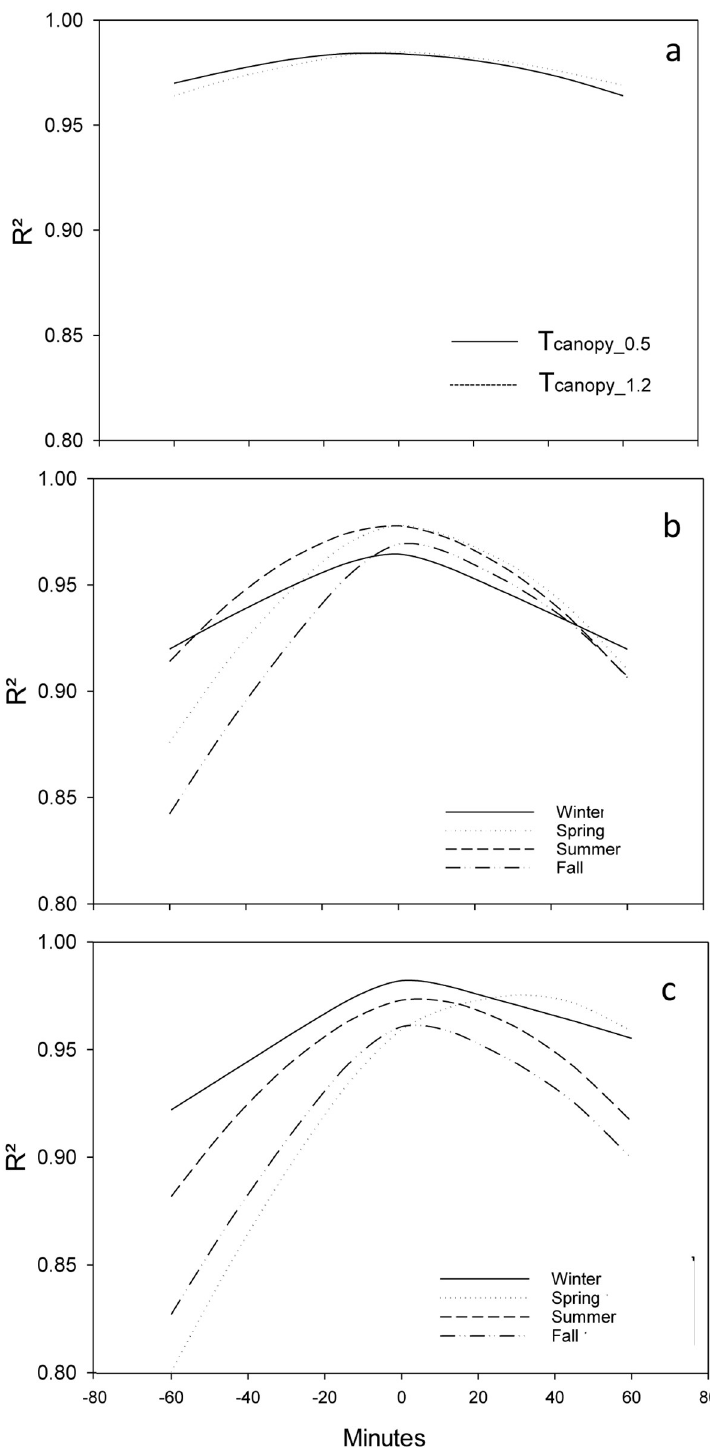
Fig 6. Cross correlation between the air temperature measured at two heights in the canopy and the weather station (a), and for the air temperature measured at 0.5 m (b) and 1.2 m (c) by season for the period December 2015 and July 2017. R 2 is the coefficient of